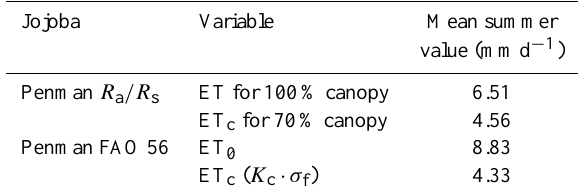
Table 5. Mean diurnal summer evaporation over Jojoba based on calculations from Penman R a /R s and Penman FAO 56. The val- ues highlighted in bold are the daily ET C or crop and canopy frac- tion adjusted estimates. As mean summer diurnal values were used to calculate ET the monthly figures shown are the same. In real- ity there may be a little variability over the summer with changing temperatures and so